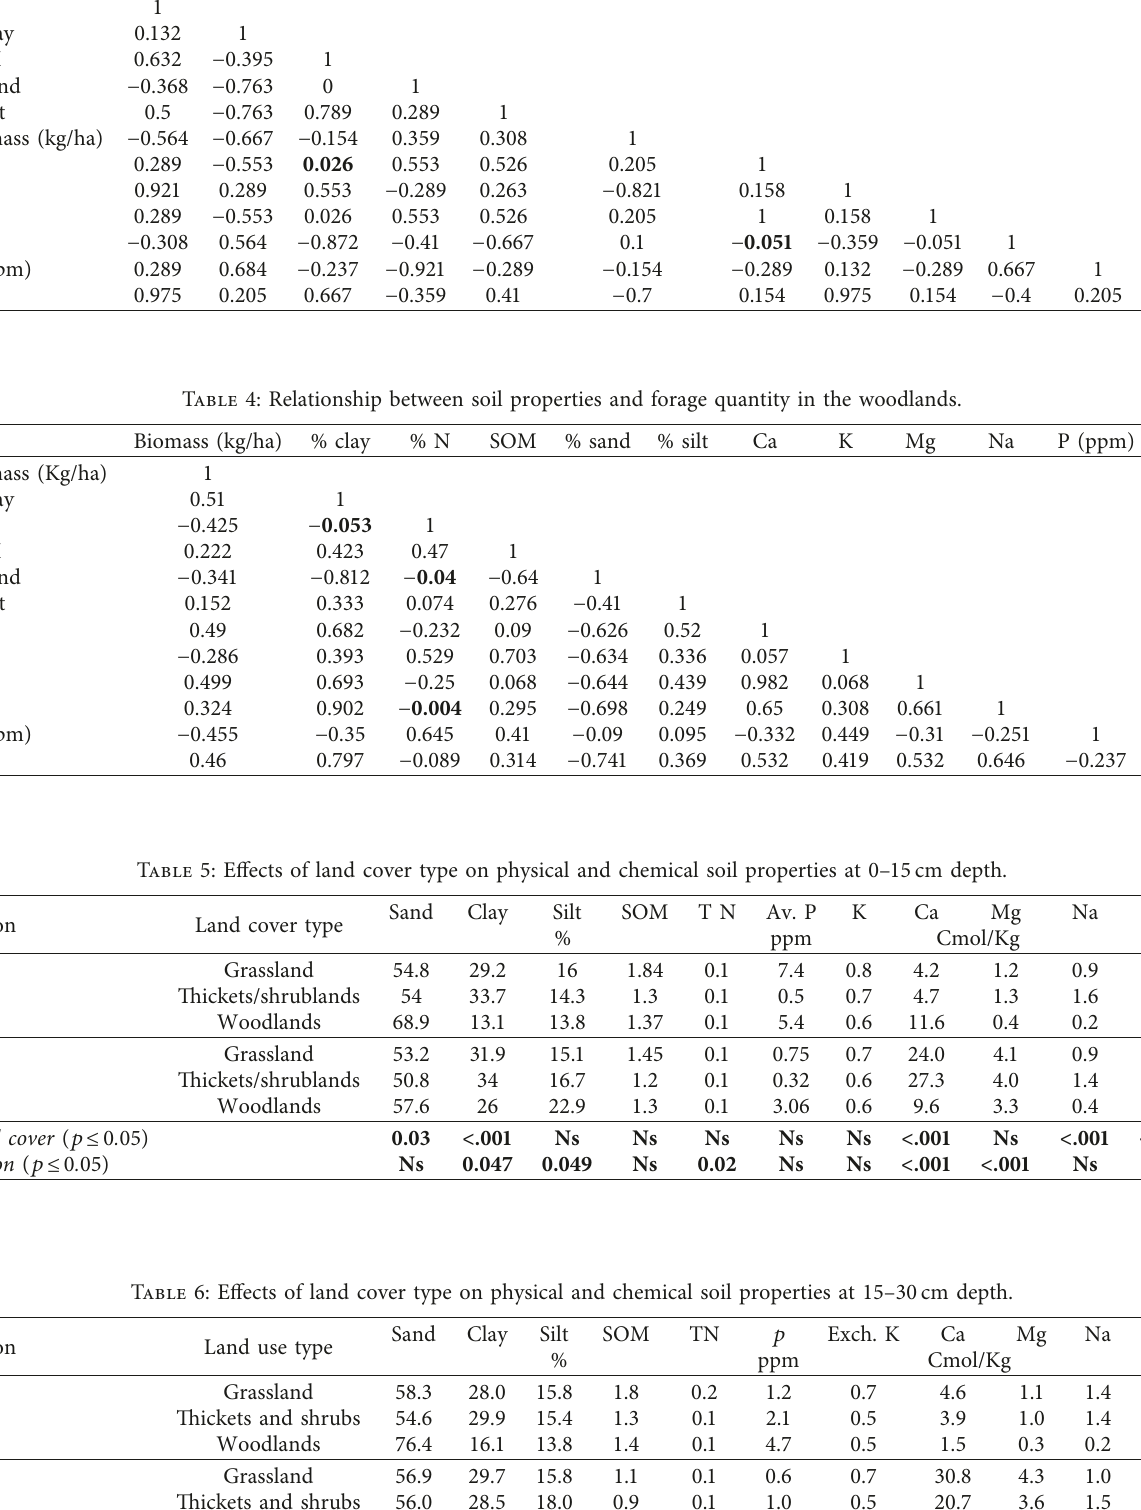
Table 3: Relationship between soil properties and forage quantity in thickets/shrublands.